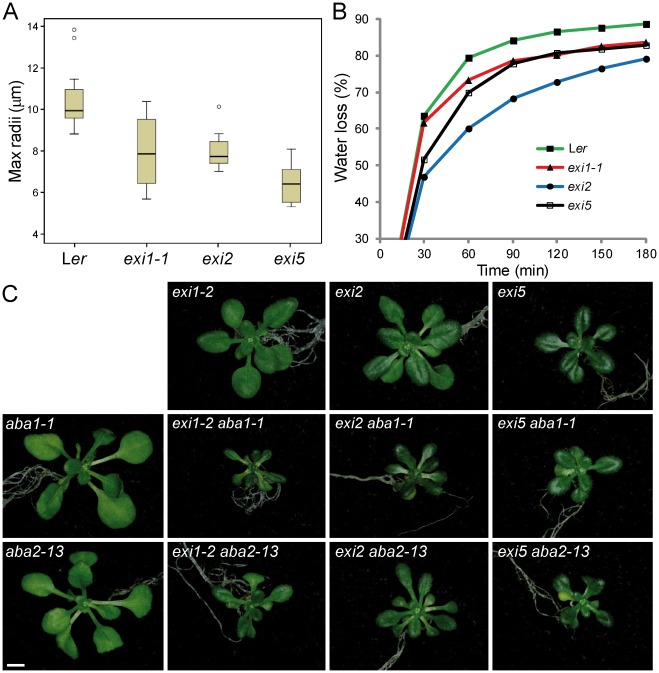
Water loss and xylem vessel size in the exi mutants.(A) Box plots showing maximal xylem vessel radius data for the exi mutants. Each box plot was produced from 15 measurements. All differences between each mutant and the wild type were statistically significant (P value<0.05). Outliers are shown as circles. (B) Rapid dehydration of detached rosettes from 4 week-old plants. Water loss was determined as percentage of initial fresh weight. (C) Rosette phenotypes caused by the exi, aba1-1 and aba2-13 mutations and their double mutant combinations. Pictures were taken 21 DAS. The scale bar indicates 1 mm.